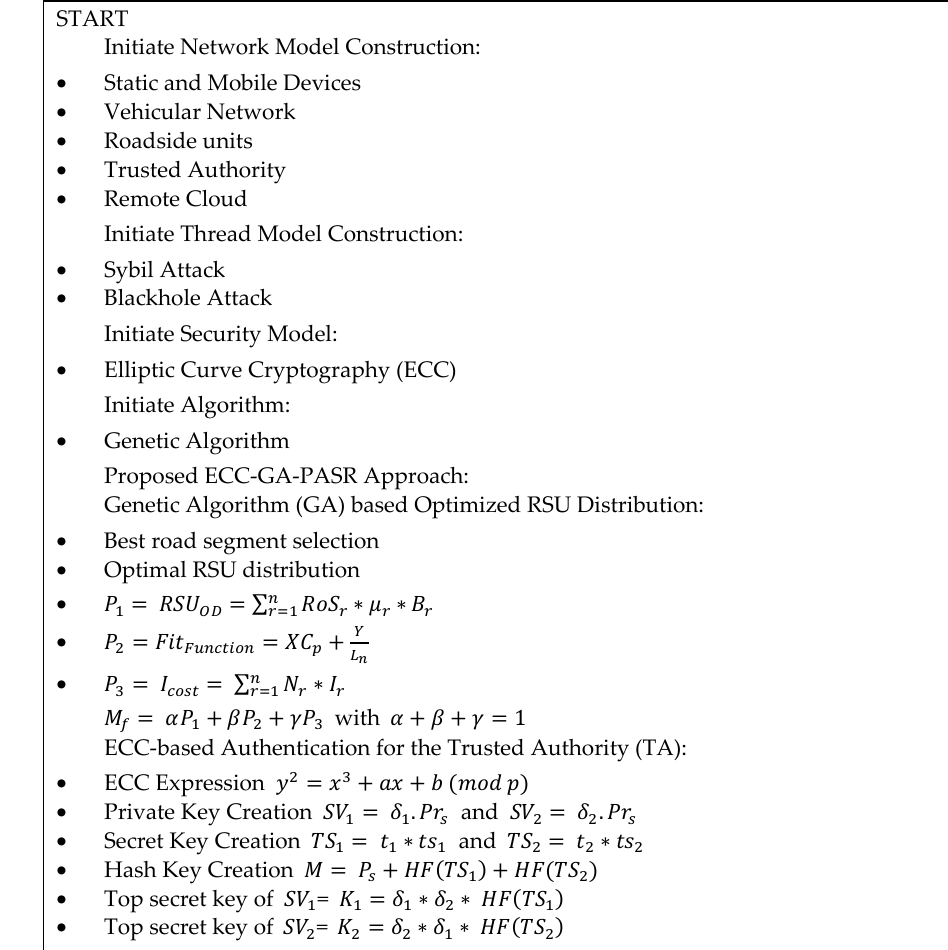
Figure 8. Vehicular Communication with ECC-based Top Secret